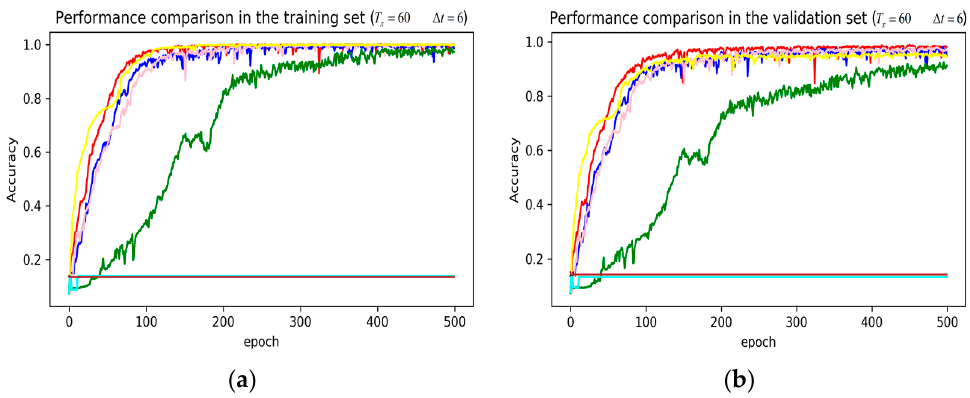
Figure 9. Performance comparison of different models in accuracy using 51 original features when setting T x to 60 samples and ∆ t to 6 samples. ( a ) Performance comparison in the training stage. ( b ) Performance comparison in the validation stage.